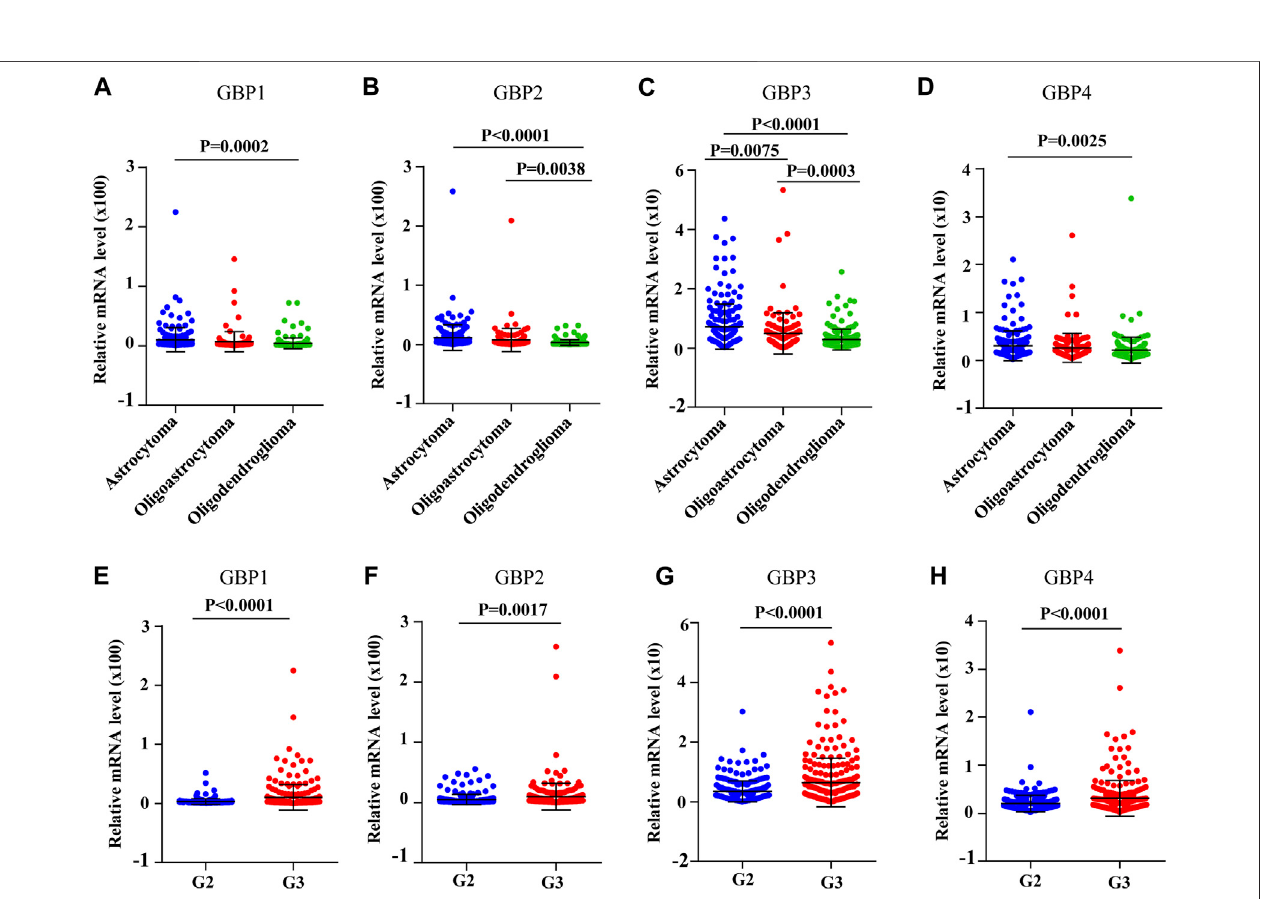
FIGURE 4| TheexpressionlevelsofGBP1/2/3/4indifferenthistologicalsubtypesandhistologicalgradesofLGG[TheCancerGenomeAtlas(TCGA)].Theexpressionlevelsof (A) GBP1, (B) GBP2, (C) GBP3,and (D) GBP4inthedifferenthistologicalsubtypesofLGG.Theexpressionlevelsof (A) GBP1, (B) GBP2, (C) GBP3,and (D) GBP4inthedifferenthistologicalgradesofLGG.